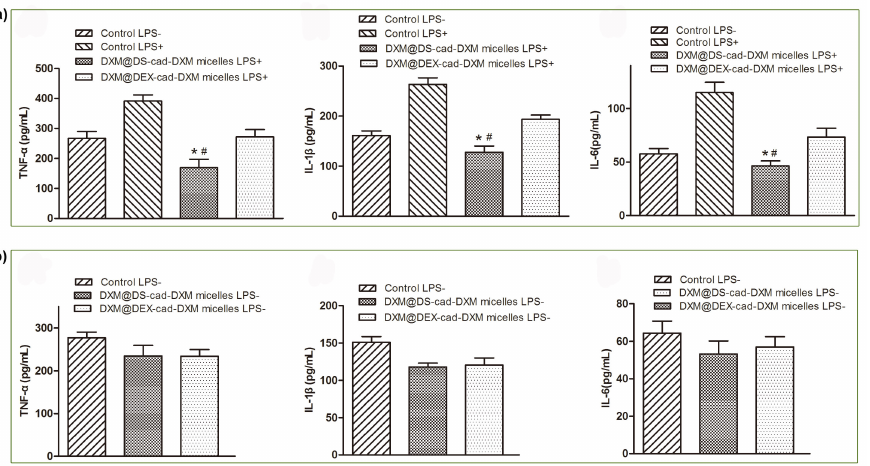
Figure 5. The levels of pro-inflammatory cytokines (TNF- α , IL-6, and IL-1 β ) after administration of DXM@DS-cad-DXM micelles and DXM@DEX-cad-DXM micelles on the activated RAW 264.7 cells ( a ) and unactivated RAW 264.7 cells ( b ). Data are presented as the mean ± SD (n = 3, * p < 0.05, # p <